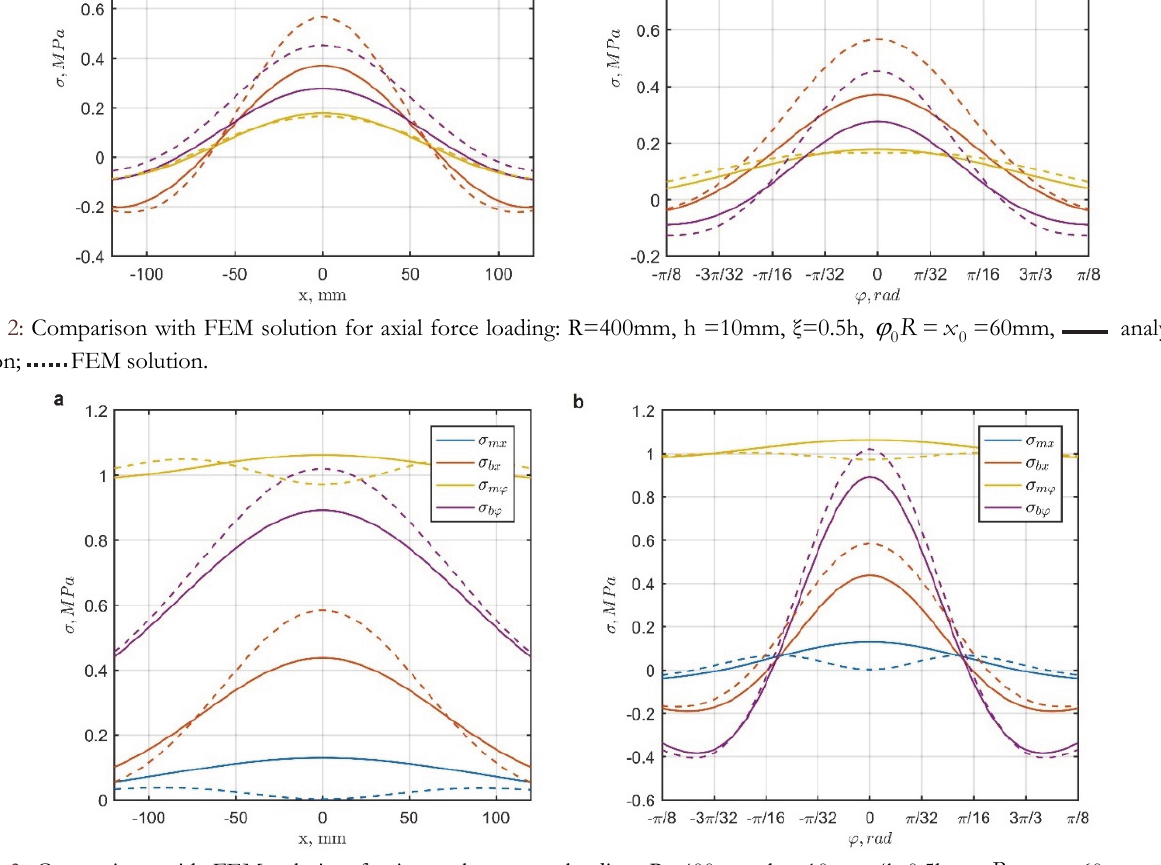
Figure 3: Comparison with FEM solution for internal pressure loading; R=400mm, h =10mm, ξ =0.5h, analytical solution; FEM